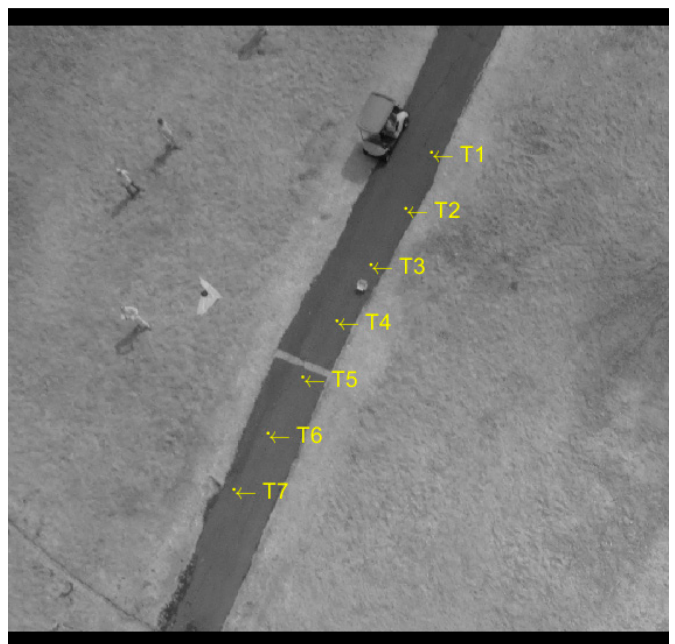
Figure 8. Moving target positions in the scene.